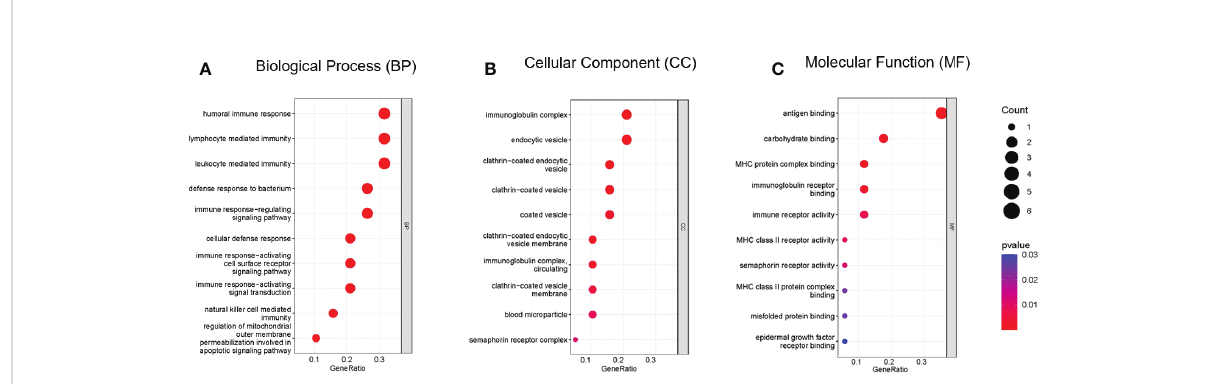
FIGURE 2 Bubble plot of gene ontology (GO) functional analysis included the respective top 10 terms in (A) biological process, (B) cellular component, and (C) molecular function, indicating that the immune differentially expressed genes (DEGs) were mainly involved in humoral immune response, lymphocyte mediated immunity, leukocyte mediated immunity, and antigen binding ( P <0.05).